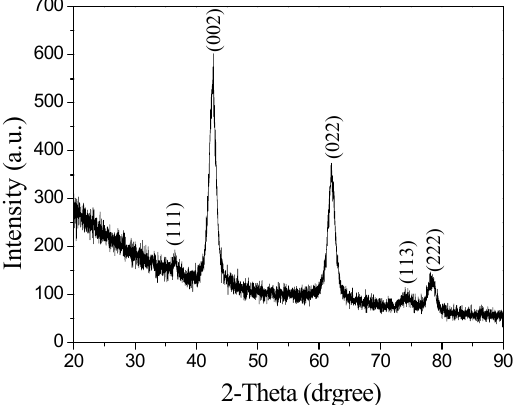
Figure 4. X-ray diffraction (XRD) pattern of the sample after calcination.